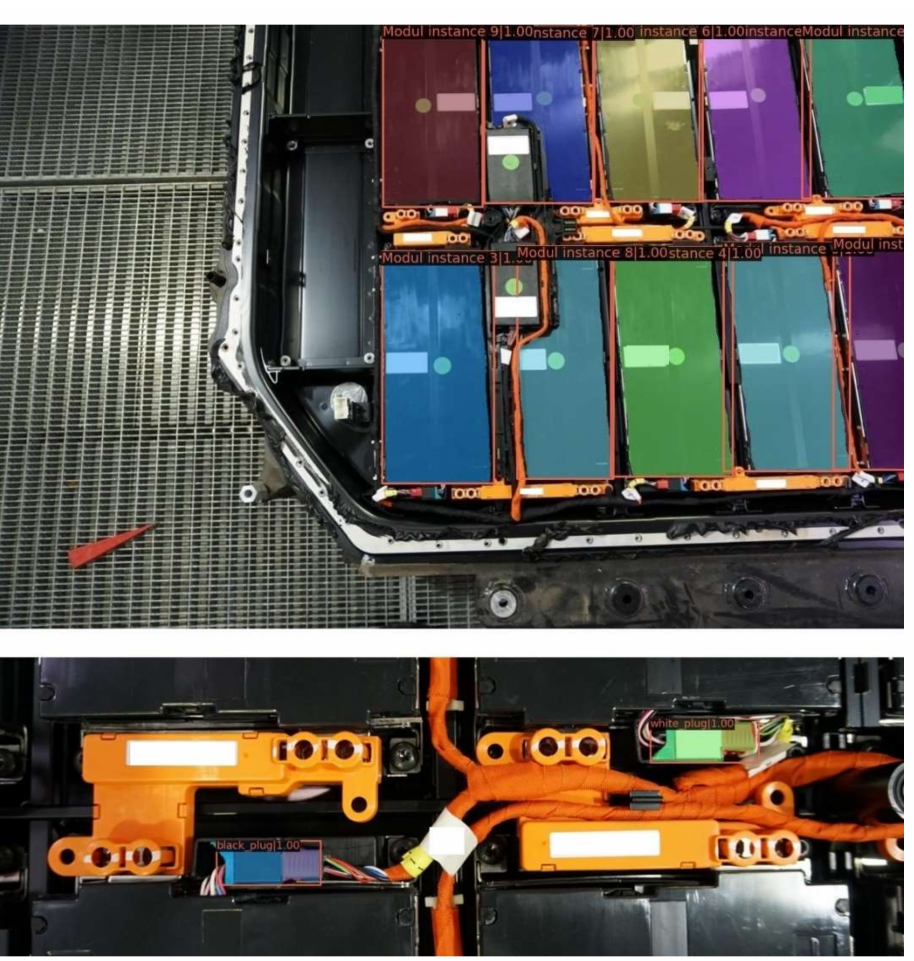
Figure 11. Instance segmentation result of modules ( top ) and plugs ( bottom